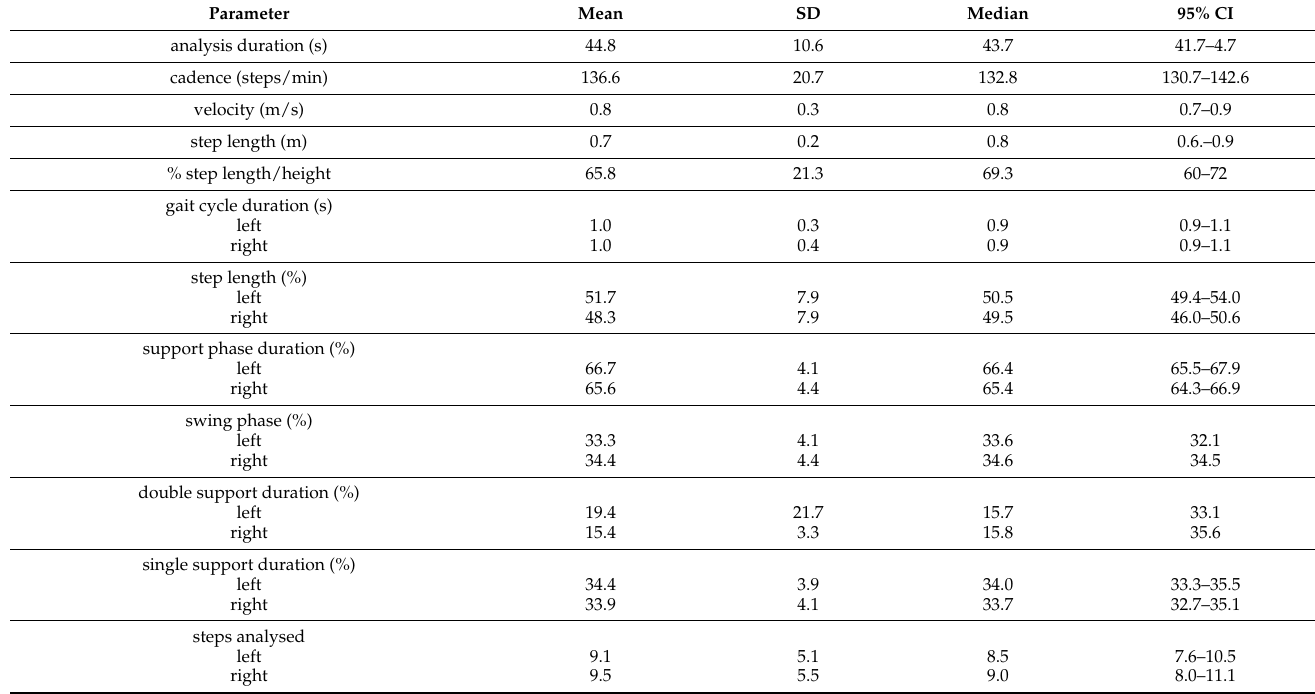
Table 1. Spatio-temporal parameters of gait in children with